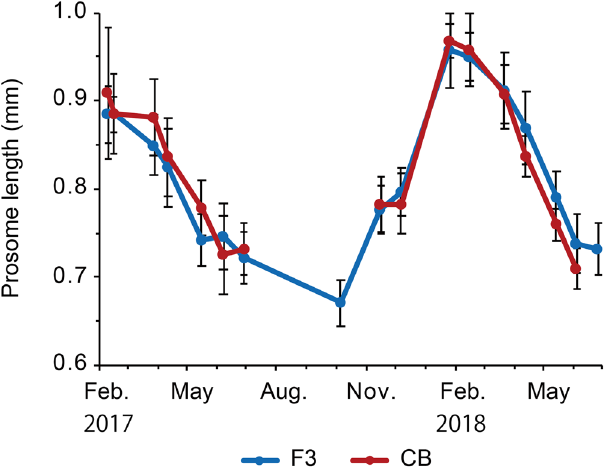
Figure 5. Seasonal changes in prosome length of adult female by used for egg production experiments of Acartia omorii at St. F3 and St. CB from February 2017 through June 2018. Error bars denote ± SD.